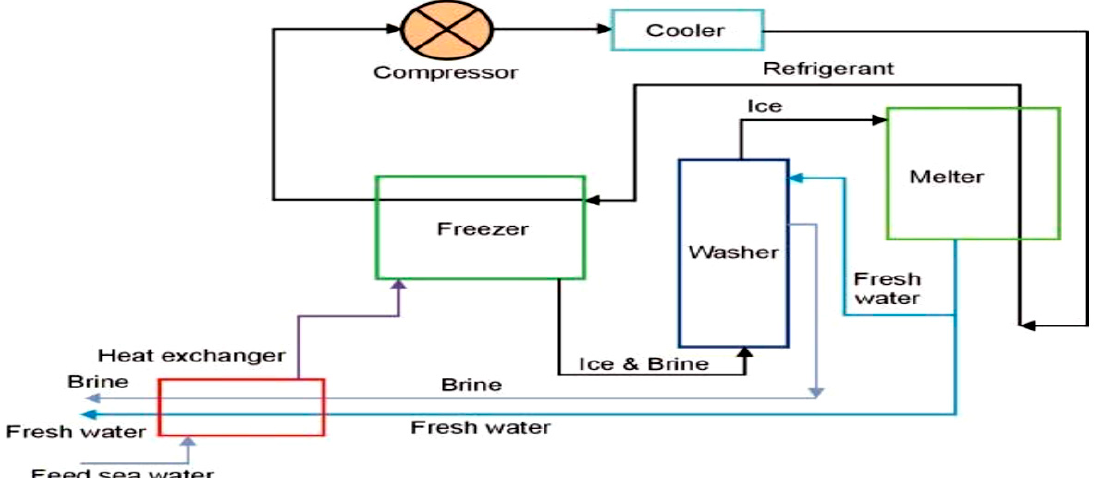
Figure 16. Indirect freezing process [105].